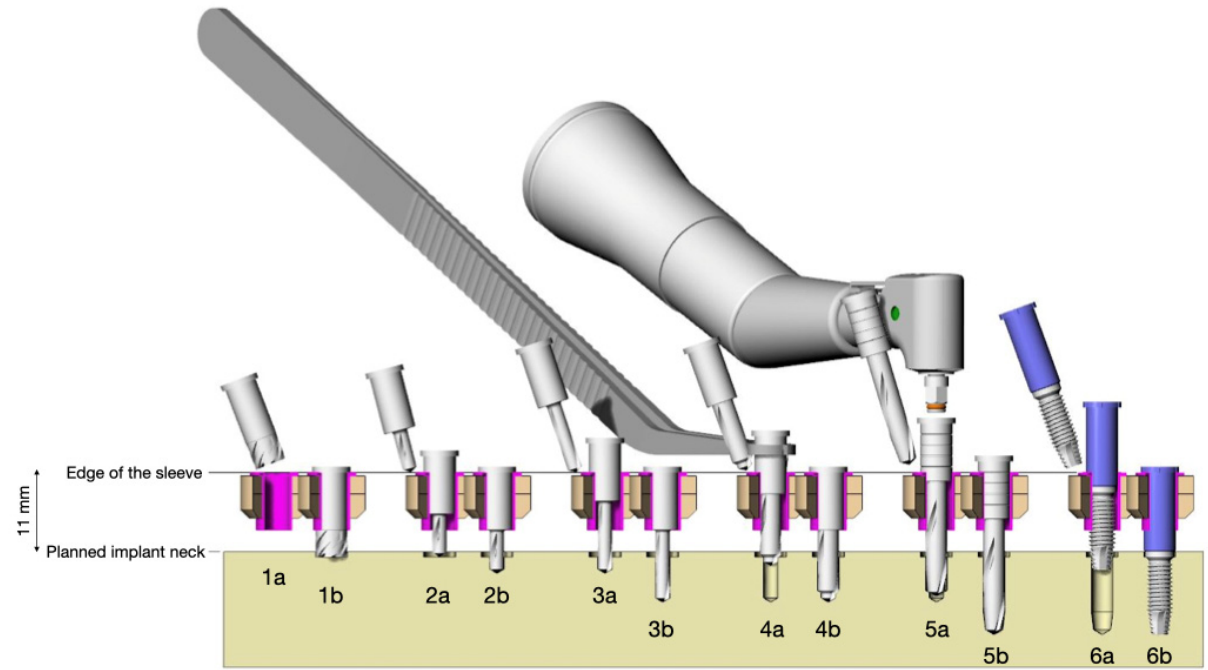
Figure 3. Guided drilling procedure. The distance between the edge of the 8-millimeter sleeves and the planned position of the implant neck is 11 mm. All the drills have to be positioned into the sleeves with dedicated tweezers and are connected to the implant handpiece by means of a unique hexagonal driver. 1: Cortical drill; 2: pilot drill; 3: 2-millimeter drill; 4: progressive drills up to the planned diameter; 5: progressive drills with horizontal depth-reference notches; 6: guided implant with a mounter (a: before insertion; b: after insertion).